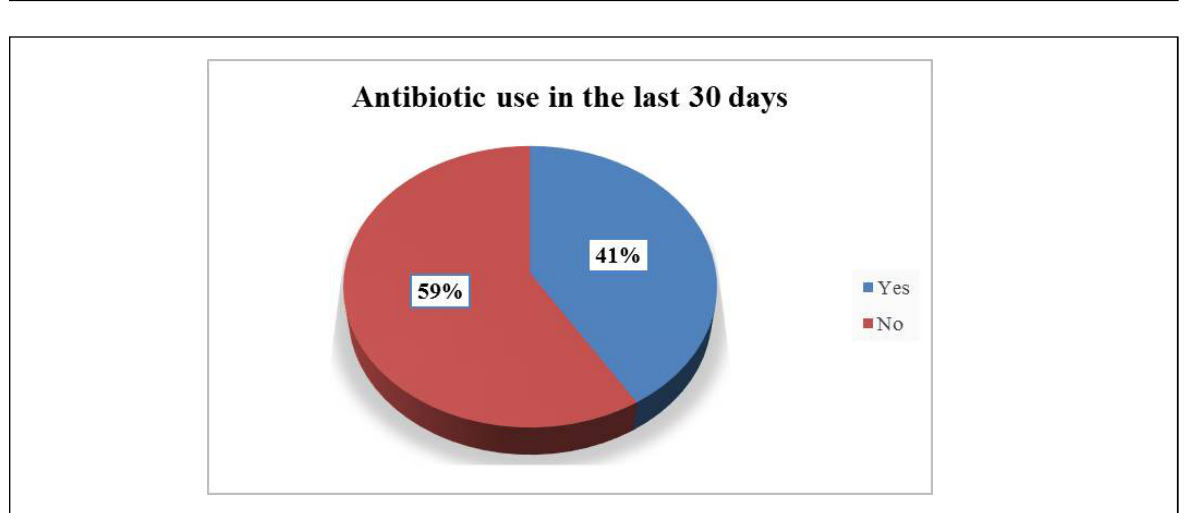
Figure 1: Distribution of antibiotics taken by the study participants in the last 30 days before hospital